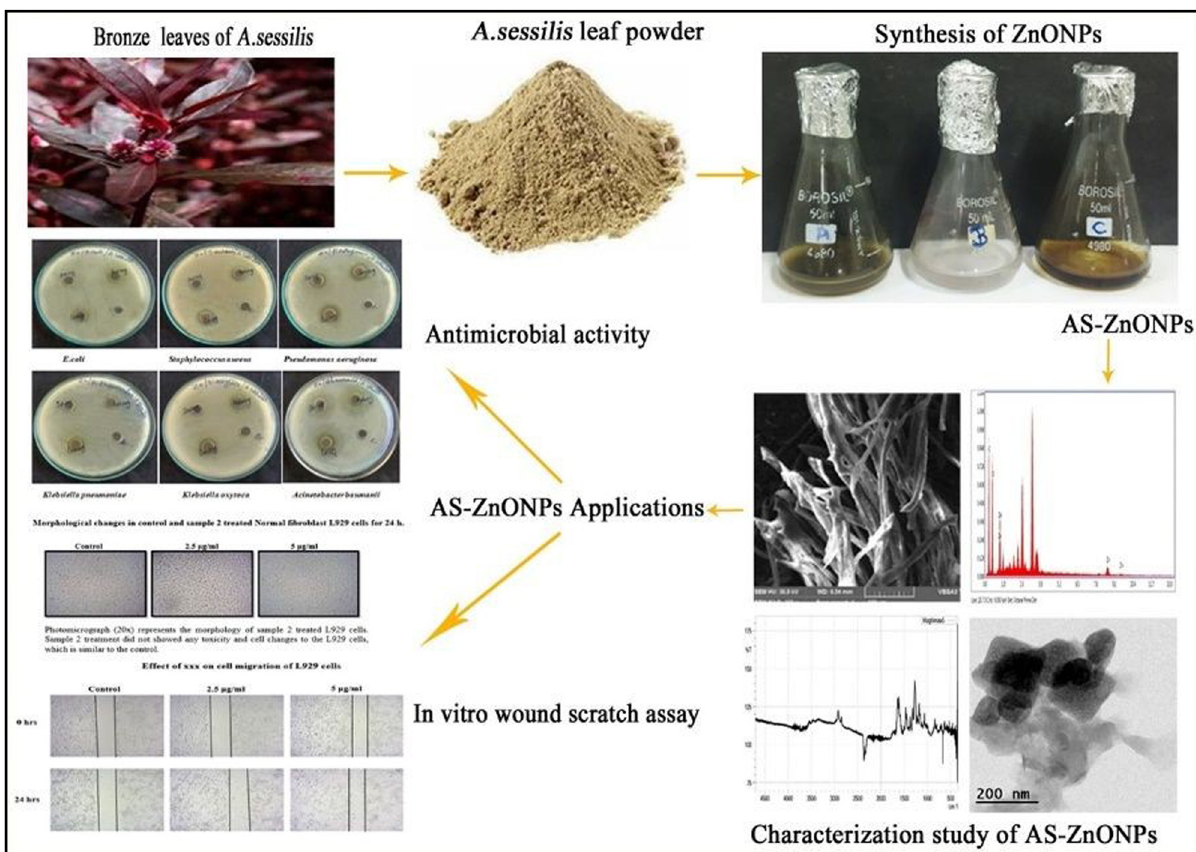
Figure 1: Graphical representation of green synthesis zinc oxide nanoparticle ( AS - ZnONPs ) coated fabrics for antibacterial wound healing potential and in vitro cytotoxic assessment using fi broblast L929 cells.